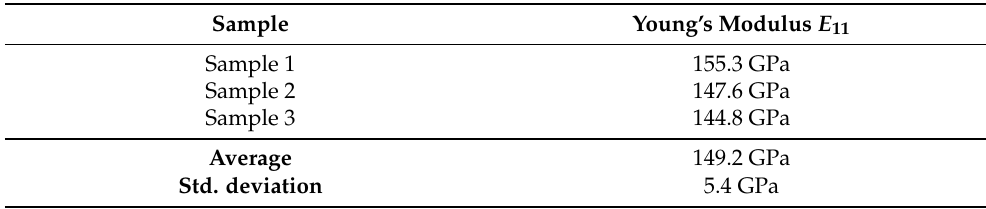
Figure 1. Tensile testing with resin cast anchor. ( a ) Sample with two strain gauges in the free length; ( b ) failed tendon showing partial fiber failure. Table 3. Measured Young’s